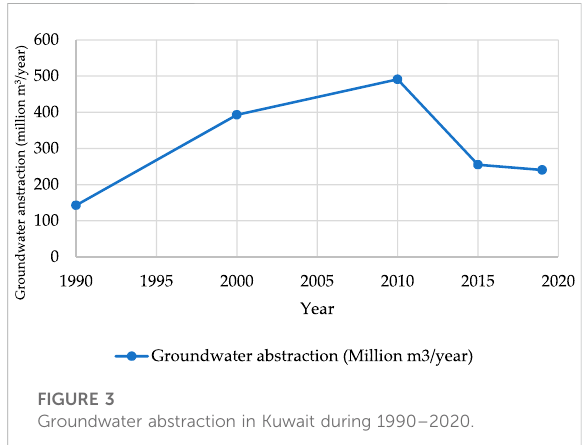
FIGURE 3 Groundwater abstraction in Kuwait during 1990 – 2020.